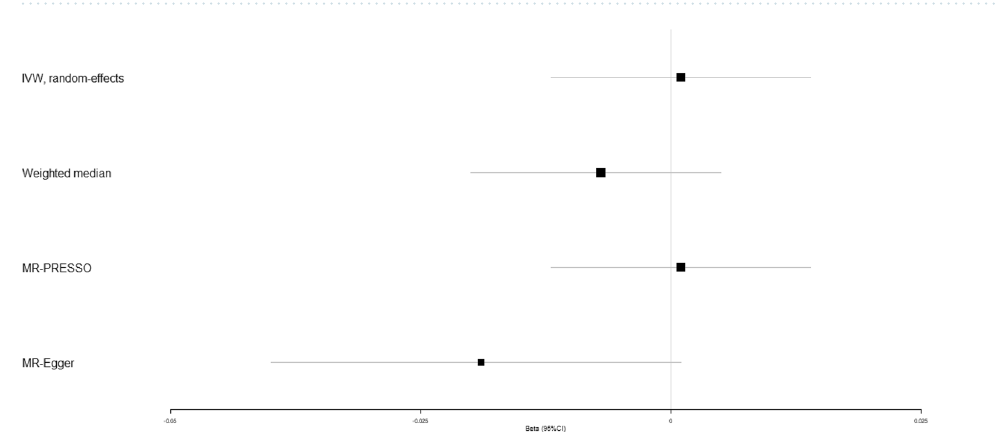
Figure 4. Beta (95% CIs) for causal influence of circulating adiponectin on atrial fibrillation through multiple